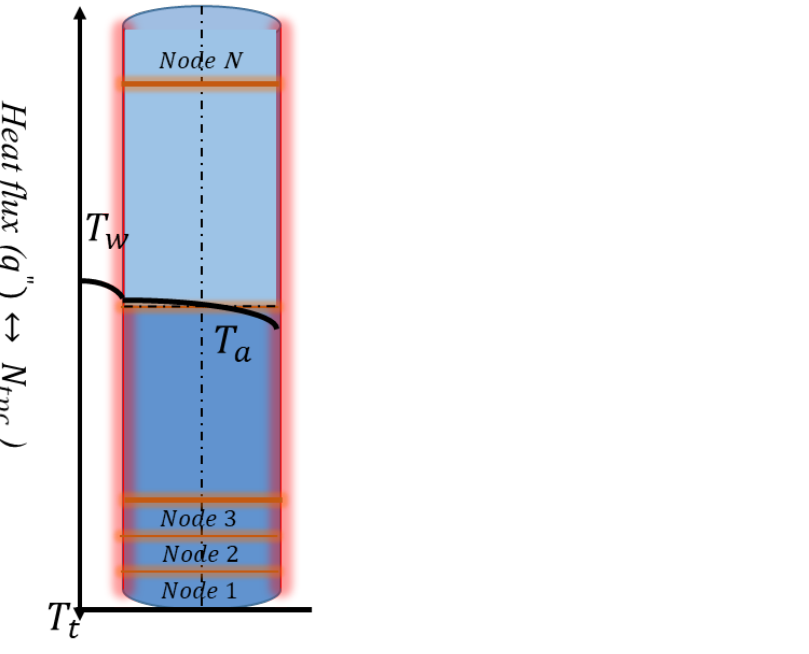
Figure 14. Symmetric view of the temperature distribution profile.